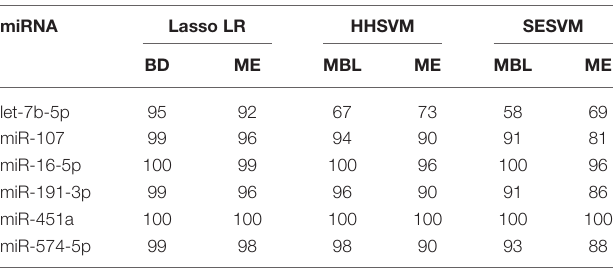
TABLE 3 | The selection frequencies (%) of candidate